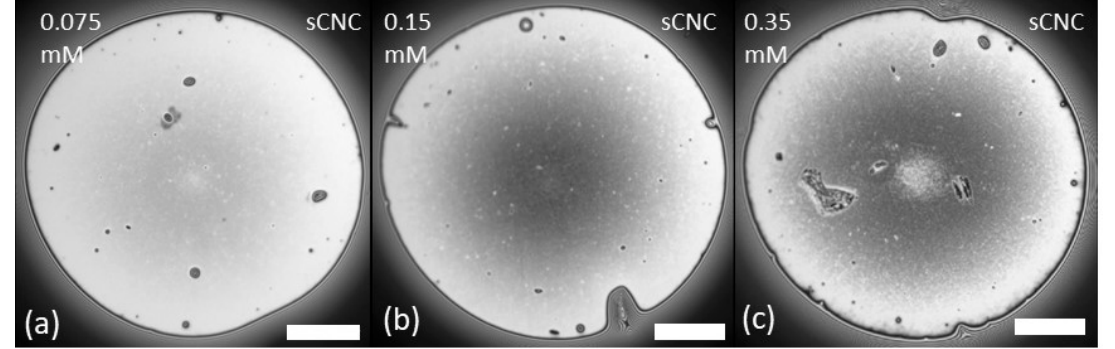
Figure 3. Morphology of LAE ‐ sCNC films at the end of drainage after the pressure step of 100 Pa. ( a ) CNC ‐ LAE 0.075 mM; ( b ) CNC ‐ LAE 0.15 mM; ( c ) CNC ‐ LAE 0.35 mM. Cellulose nanocrystal concentration, 0.3 wt%. Scale bar is 100 μ m.